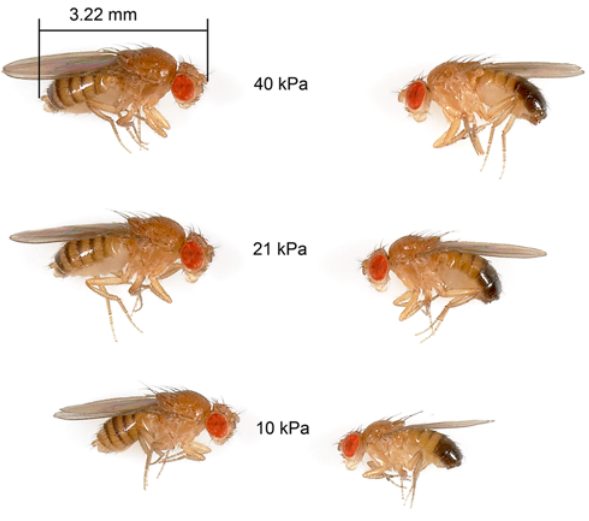
Figure 1. Drosophila melanogaster specimens (females left, males right) from the large size-selected populations main- tained in their test aPO 2 s. The flies in 21 and 40 kPa had very similar body sizes but those maintained in 10 kPa exhibited strong size suppression despite having undergone strong size selection for 11